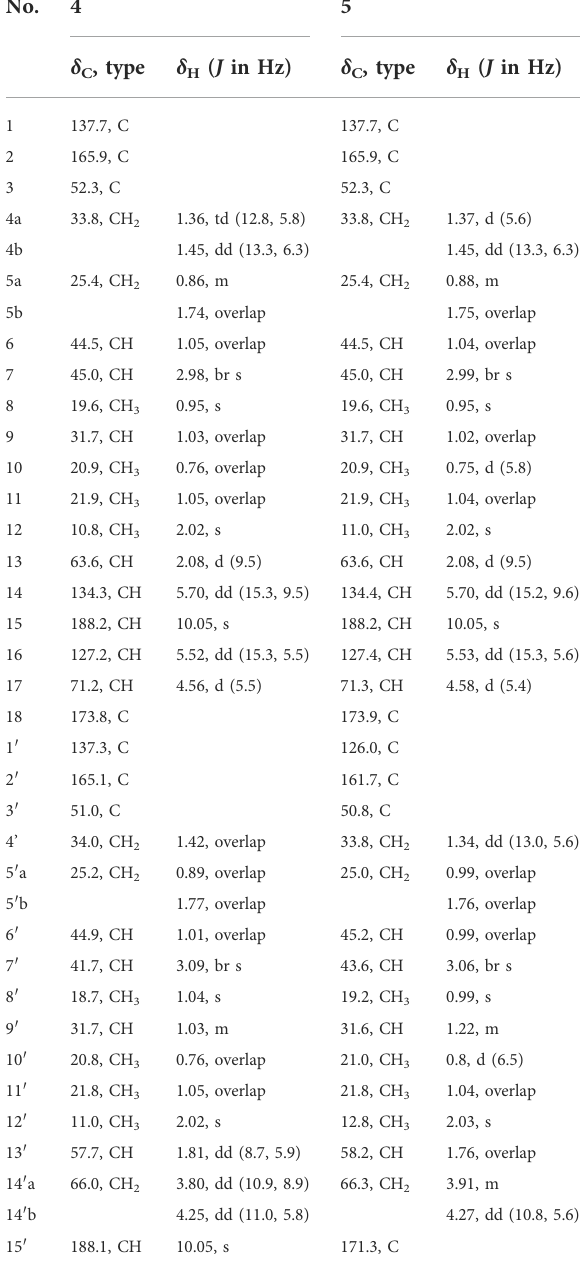
TABLE 2 1 H and 13 C NMR data for 4 and 5 in CDCl 3